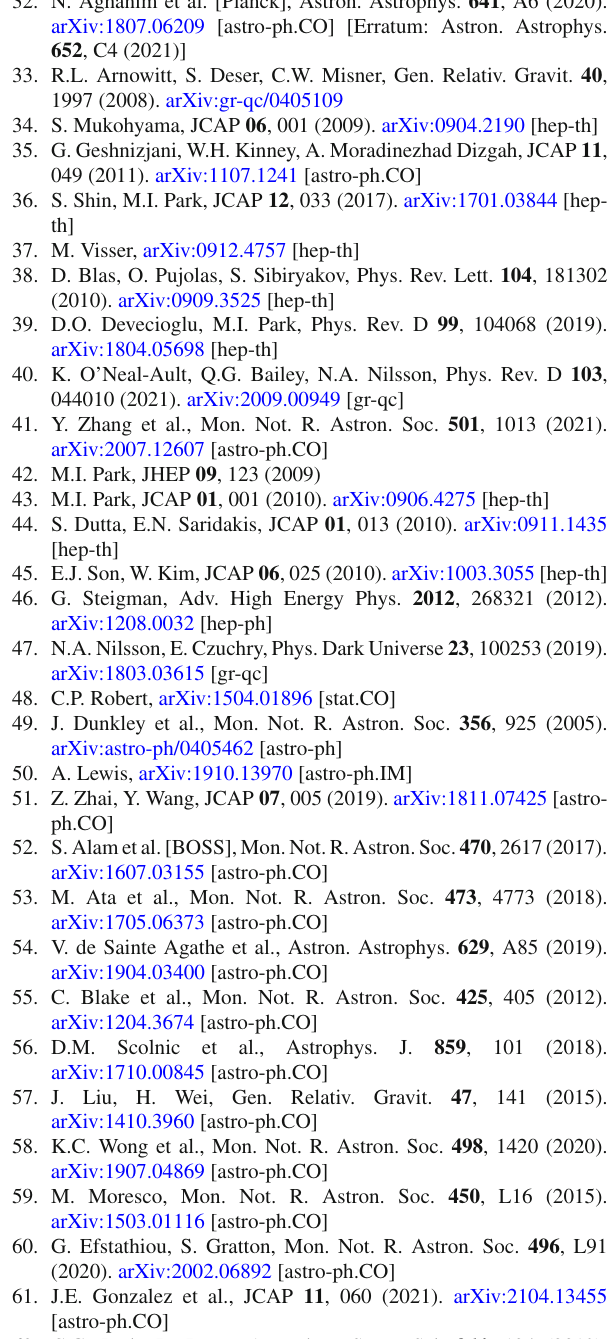
Table 2 Constraints at 1 σ CL on the theory parameters for our